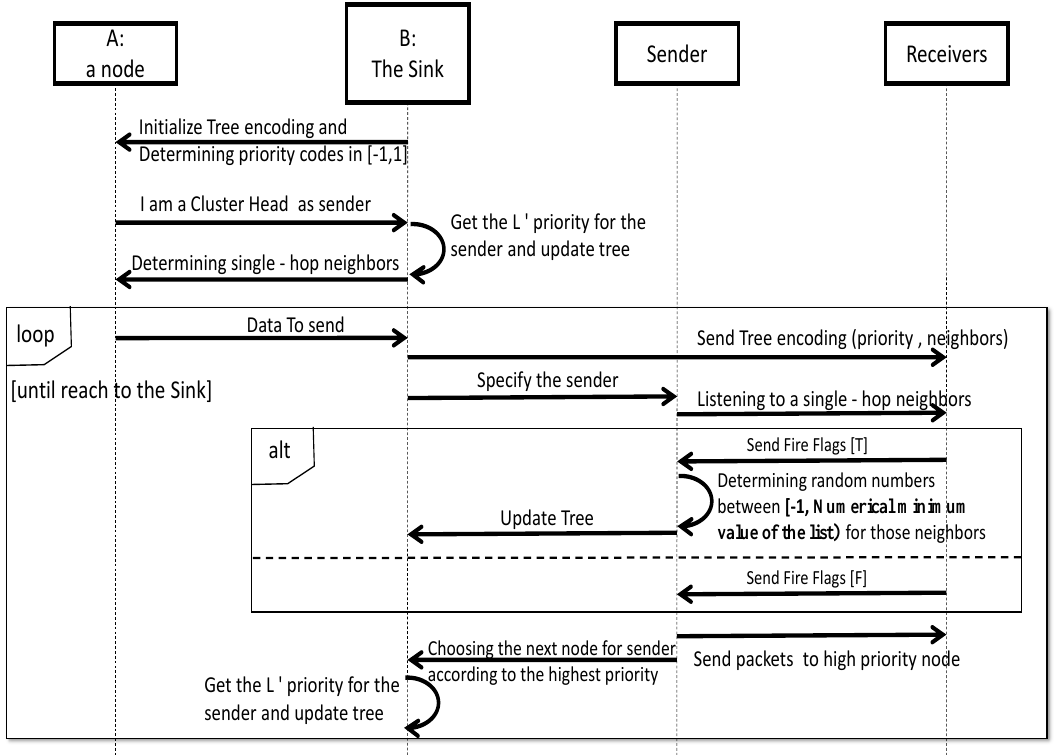
Figure 3. UML sequence diagram of tree encoding for each